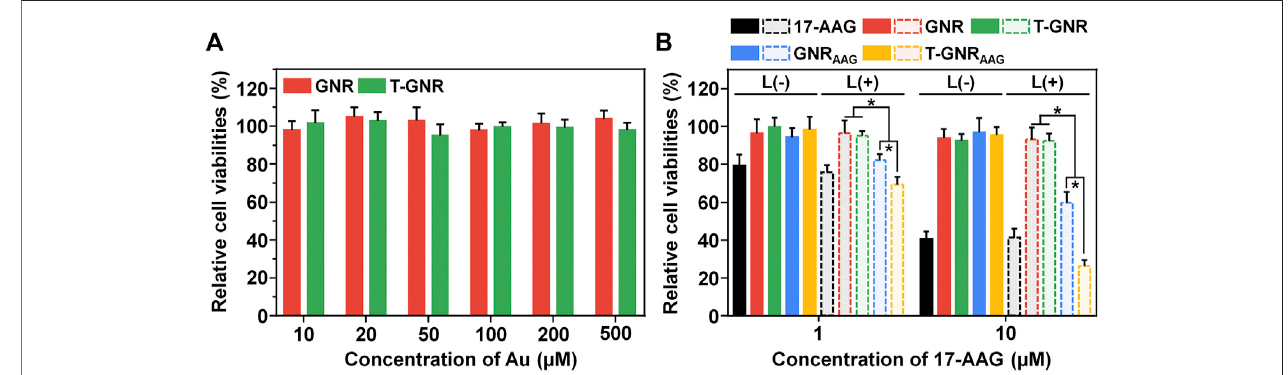
FIGURE 6 | (A) Plasma 17-AAG concentration vs. time after systemic administration of free 17-AAG, GNR AAG , or T-GNR AAG (n = 4). The area under curve (B) and half-life (C) of free 17-AAG, GNR AAG , and T-GNR AAG . * p < 0.05 vs. GNR AAG . (D) Quantitative 17-AAG content in HepG2 tumors at 6, 12, and 24 h postinjection. (E) Quantitative 17-AAG content in major organs of tumor-bearing mice at 24 h postinjection.